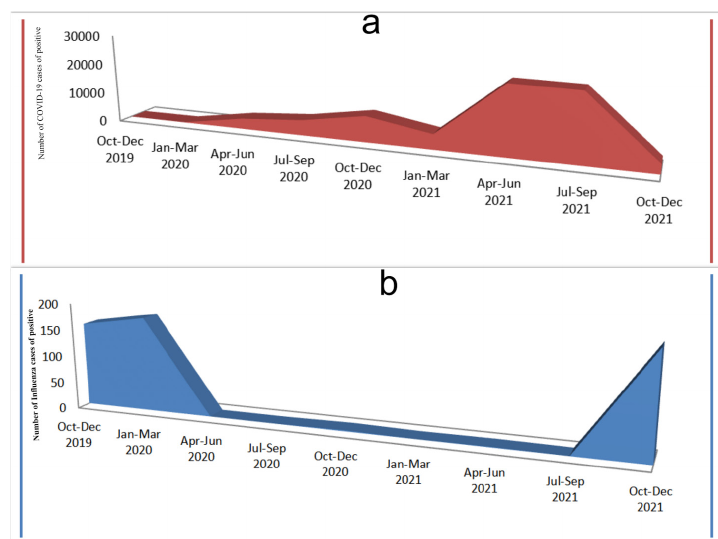
Figure 1. The Flowchart of Prevalence of Influenza (a) and COVID-19 (b) During 2019-2021 in Hormozgan Province. Note. COVID-19: Coronavirus disease